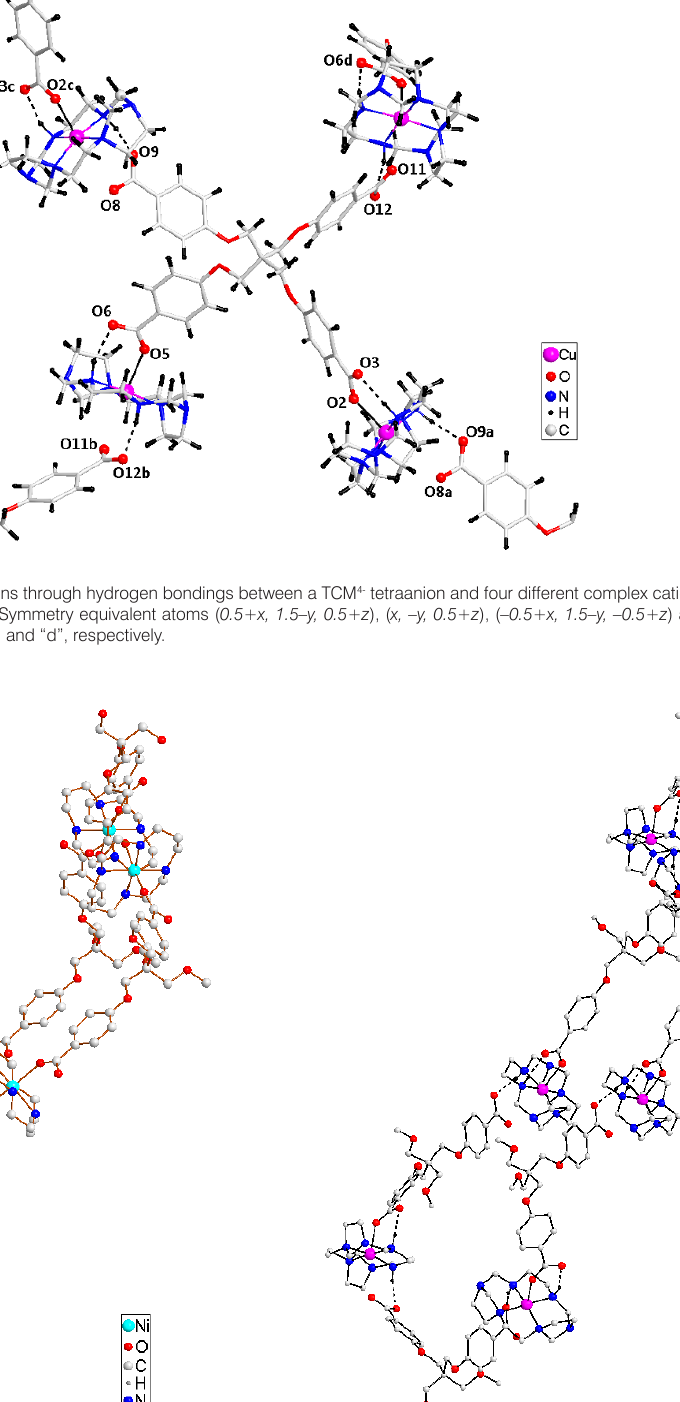
[TCM]•2DMF•10H O 2 2